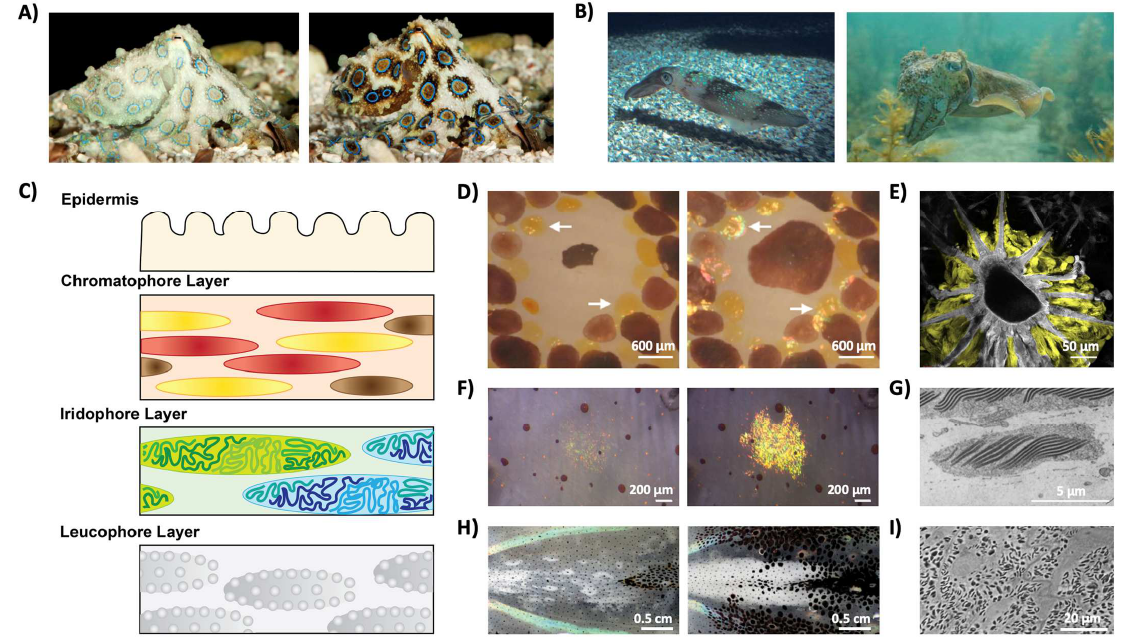
Figure 4. The color-changing abilities of cephalopods and their complex skin architectures. ( A ) Images of a blue-ringed octopus ( Hapalochlaena lunulata ) changing its coloration. ( B ) Images of a Loligo pealeii squid ( left ) and a Sepia apama cuttlefish ( right ). ( C ) A schematic of squid skin showing their complex skin architecture, which contains an outer epidermis and layers of chromatophore organs, iridophore cells, and leucophore cells. ( D ) The contracted ( left ) and expanded ( right ) forms of a chromatophore organ, where the white arrows show the presence of iridophores. ( E ) An electron microscopy image of a chromatophore organ, where the portions highlighted in yellow indicate the positions of sheath cells. ( F ) The non-iridescent ( left ) and iridescent ( right ) forms of an iridophore cell. ( G ) An electron microscopy image of an iridophore cell showing the intracellular lamellar structures (dark gray) that enable the narrowband reflectance characteristic of the cell. ( H ) The transparent ( left ) and opaque ( right ) tissue in the mantle of a female Doryteuthis opalescens squid. ( I ) An electron microscopy image of the layer of leucophores showing the electron dense proteinaceous particles called leucophores (dark gray) that enable the dynamic opacity-changing capabilities of the squid. The images in part A are reproduced from [36]. The images in part B are reproduced from [40]. The images in parts D and E are reproduced from [43]. The images in part F are reproduced from [46]. The image in part G is reproduced from [44]. The images in parts H and I are reproduced from [53]. Table 1. The refractive indices of optically-active biomolecules.